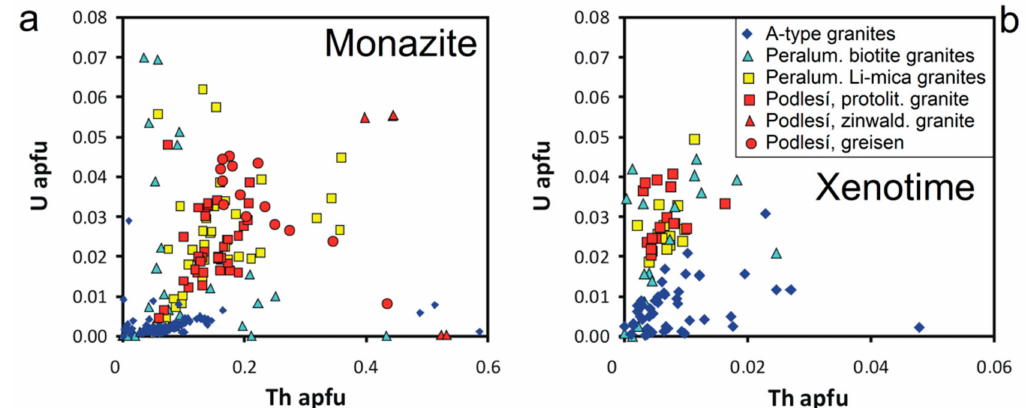
Figure 8. U/Th values in minerals. ( a ) monazite; ( b ) xenotime.